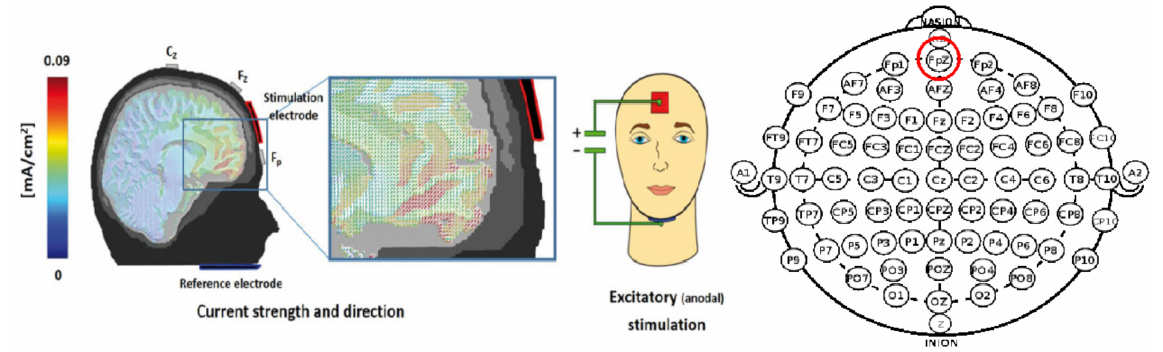
Figure 6. Electrode placement and current modelization. Adapted from the figure published in Junghöfer et al., 2017 [42] with permission of the